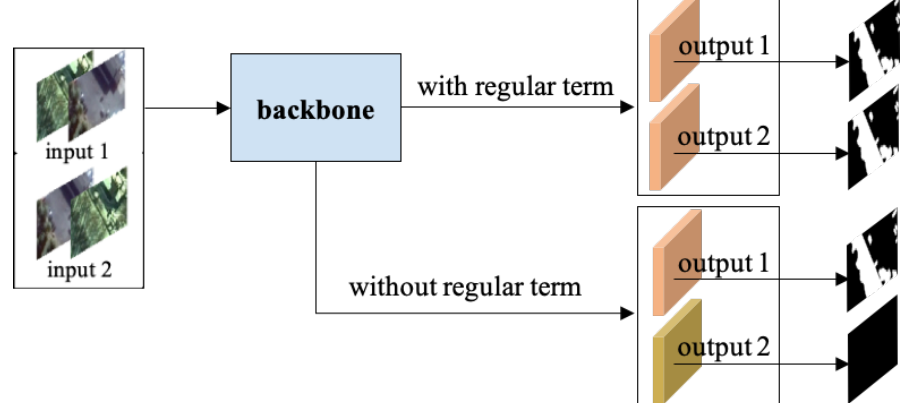
Figure 1. The principle of the regular term in the objective function.The red blocks are temporal- reliable features. The yellow blocks are not robust features and need to be corrected by the regular term in the objective